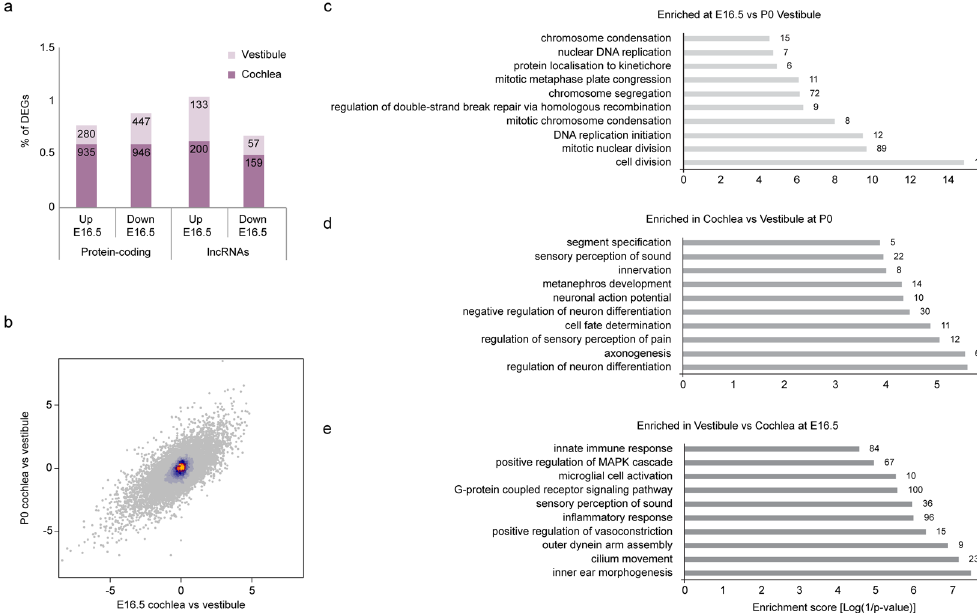
Figure 4. Functional annotation of differentially expressed genes (DEGs). ( a ) Bar graph comparing the number of DEGs (adjusting P < 0.05, a fold change of at least 2) at E16.5, in the vestibule compared to cochlea. The percentage was calculated from the total coding and non-coding transcripts, 15,916 and 3,239, respectively. ( b ) Scatter plot of pairwise log2 fold changes for the cochlea vs vestibule DEGs between E16.5 (x-axis) and P0 (y-axis). ( c – e ) Top ten TopGO functional gene ontology (GO) annotations for the DEGs. Bar graphs show all three GO information categories (biological processes, molecular functions, and cellular components). The abscissa represents the number of DEGs. All GO categories listed exhibit enrichment with p < 0.05. ( c ) Enriched in vestibule at E16.5 vs P0. ( d ) Enriched at E16.5 in vestibule vs cochlea. ( e ) Enriched at P0 in cochlea vs